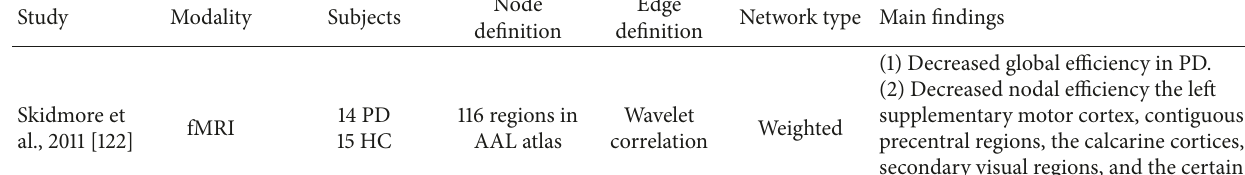
Table 7: Overview of functional brain network studies in